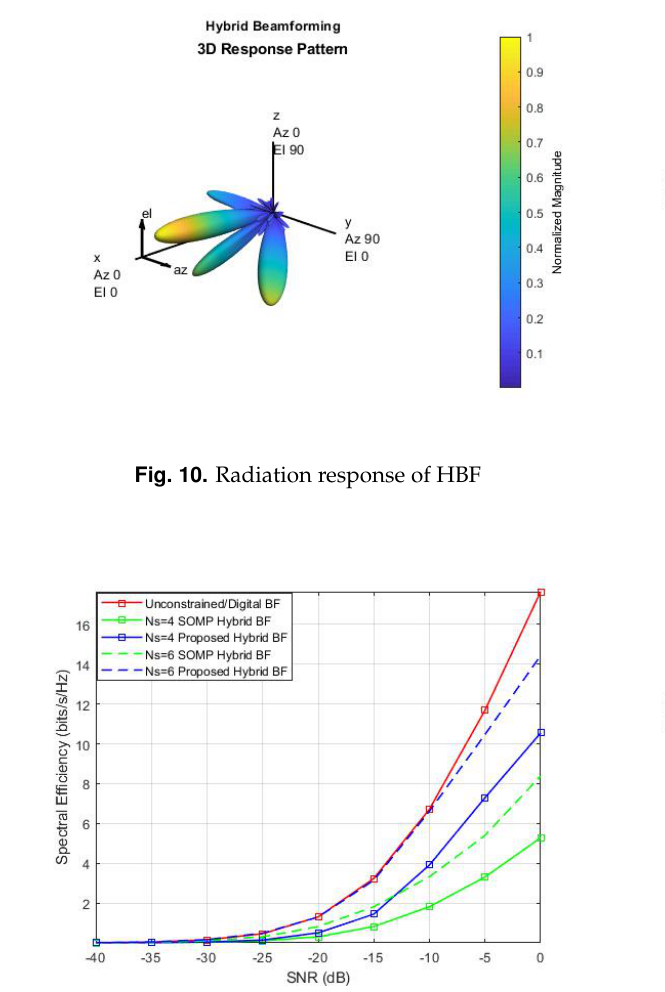
Fig. 11. Spectral efficiency for ULA